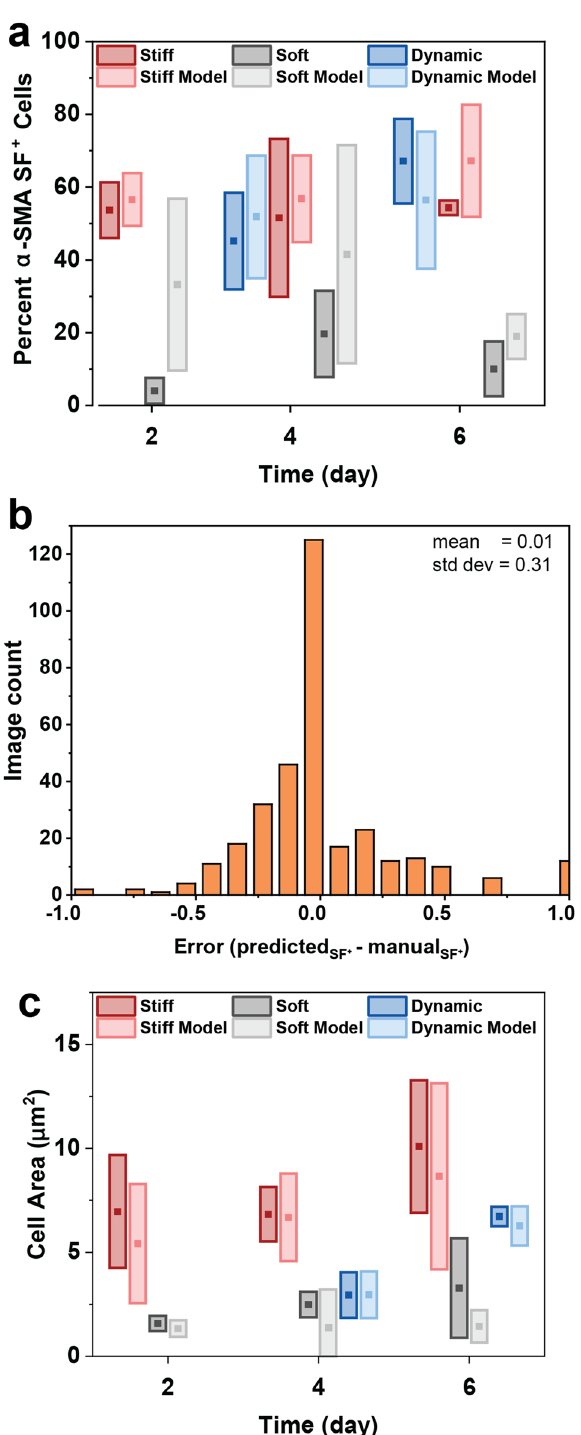
Figure 5. ( a ) Percentage of α-SMA SF + cells predicted by the model (light bars) and manual identification (dark bars). ( b ) Visualization of the difference between model and manual identification on an individual image scale. For 98/306 images, the results matched exactly. ( c ) Comparison of average cell area predicted by the model (light bars) and manual analysis (dark bars). Detailed statistics are shown in Tables S1 and